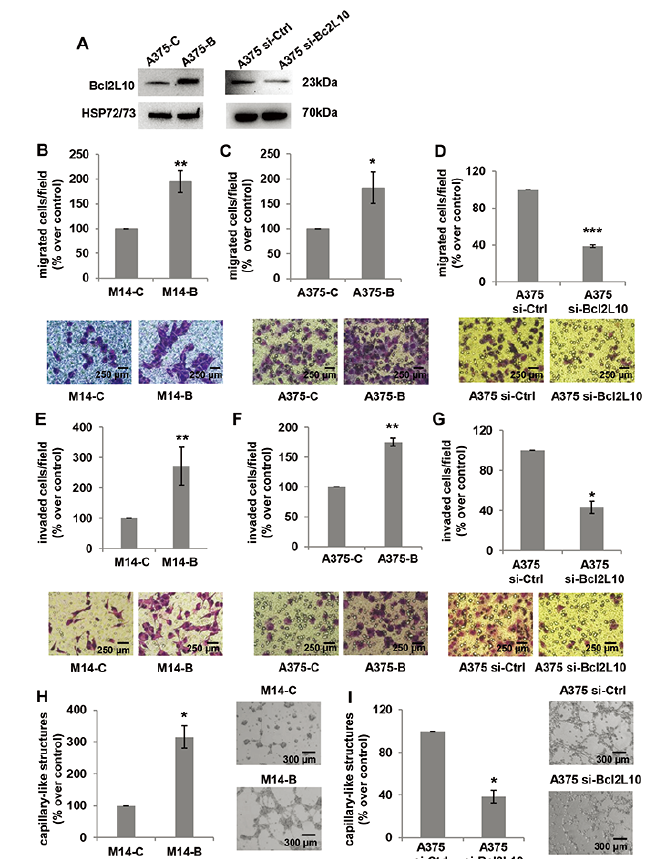
Figure 2. Bcl2L10 promotes in vitro melanoma cell invasion, migration and VM. (A) Western blot analysis of Bcl2L10